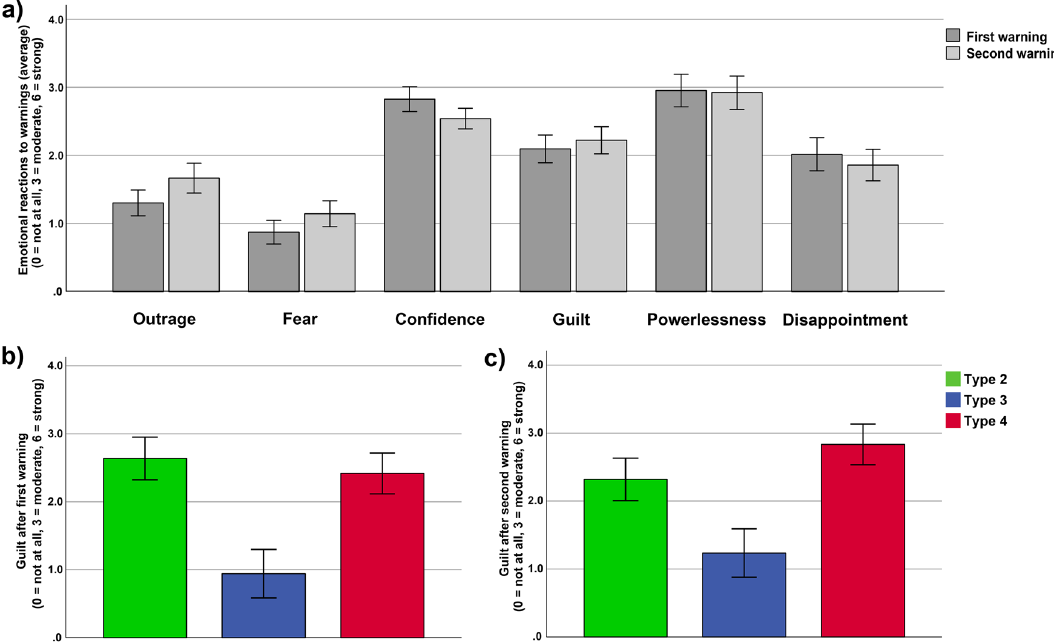
Figure 4. Average emotional reactions to the warnings and distinct emotional reactions of the three behavioural types. The bar graph in ( a ) illustrates the emotional reactions to the first and second warning, irrespective of behavioural types. On average, participants felt little outrage and fear, low to moderate levels of guilt and disappointment, and moderate levels of confidence and powerlessness after both the first and second warning. The bar graphs in ( b ) and ( c ) illustrate that type 2 and type 4 reported a moderate level of guilt after both warnings, which was significantly higher than the level of guilt reported by type 3, who felt only little guilt. Error bars depict standard errors of the